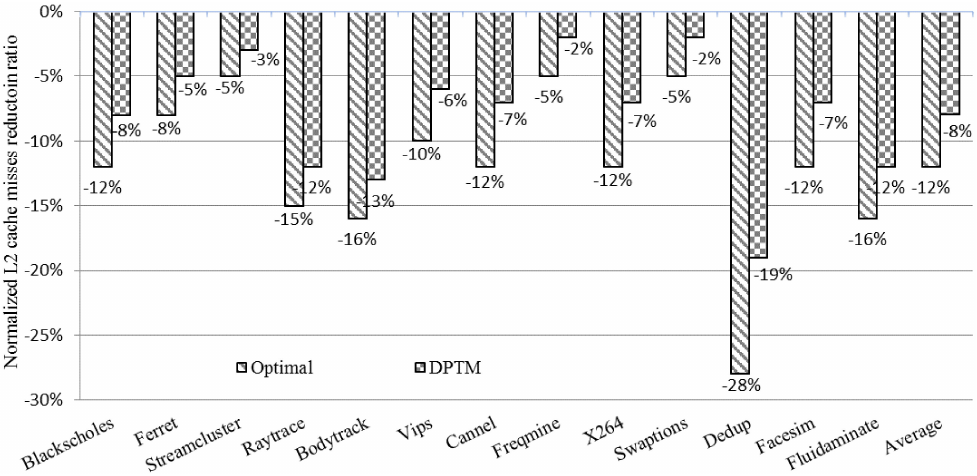
Figure 7. Reduction of the last-level cache